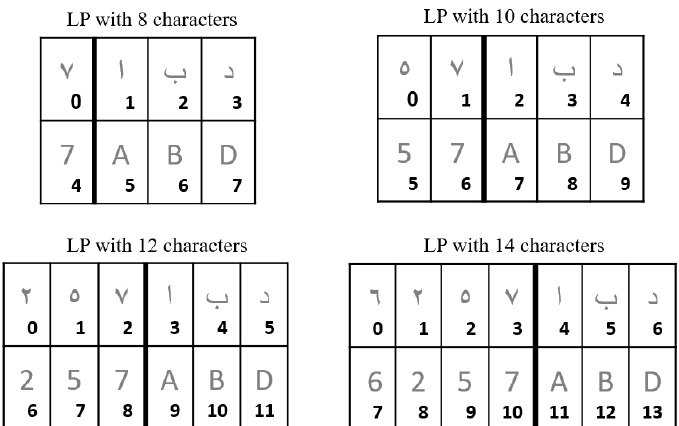
Figure 4. Example showing the possible number of characters on Saudi license plates. There are always three letters, but the number of digits varies from 1 to 4. Each letter is written in both Arabic (first line) and Latin (second line) characters, and each digit is written in Eastern Arabic (first line) and Western Arabic (second line) numerals. For later use, each character is marked with an index (CharID) representing its order from left to right and top to bottom.